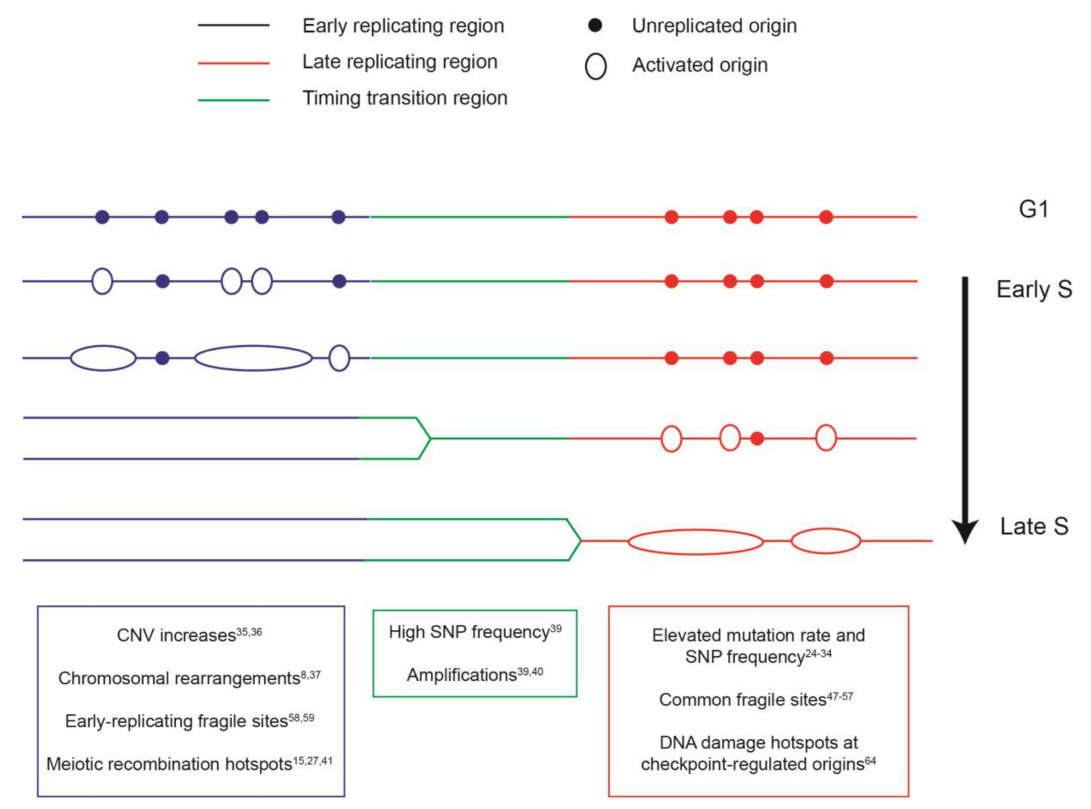
Figure 1. Schematic of the replication program and genome instability events associated with different replication domains. Colors correspond to the timing of replication of a giving region in the synthesis (S) phase. Blue: early-replicating domain, red: late-replicating domain, and green: timing transition region. Unreplicated origins are indicated by closed circles; initiated and elongating origins are shown as open circles and ovals. The distinct genome instability features that are enriched in each replication domain are indicated in the boxes below, with the relevant references noted. CNV: copy number variation. SNP: single-nucleotide